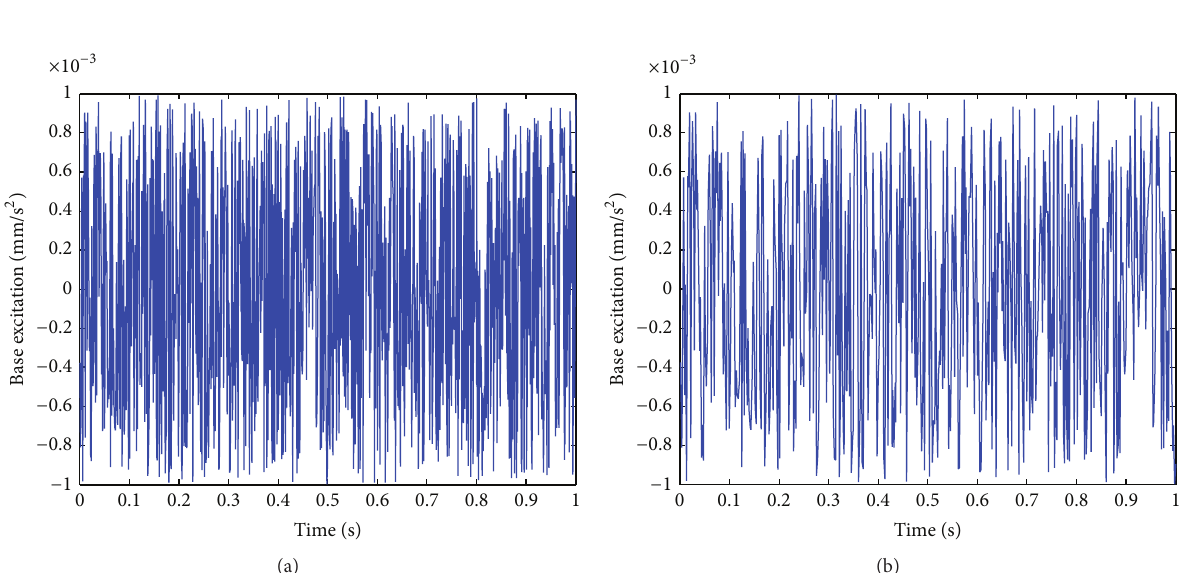
Figure 2: Acceleration of external excitation at the left support: (a) time step of 0.001 sec, (b) time step of 0.002